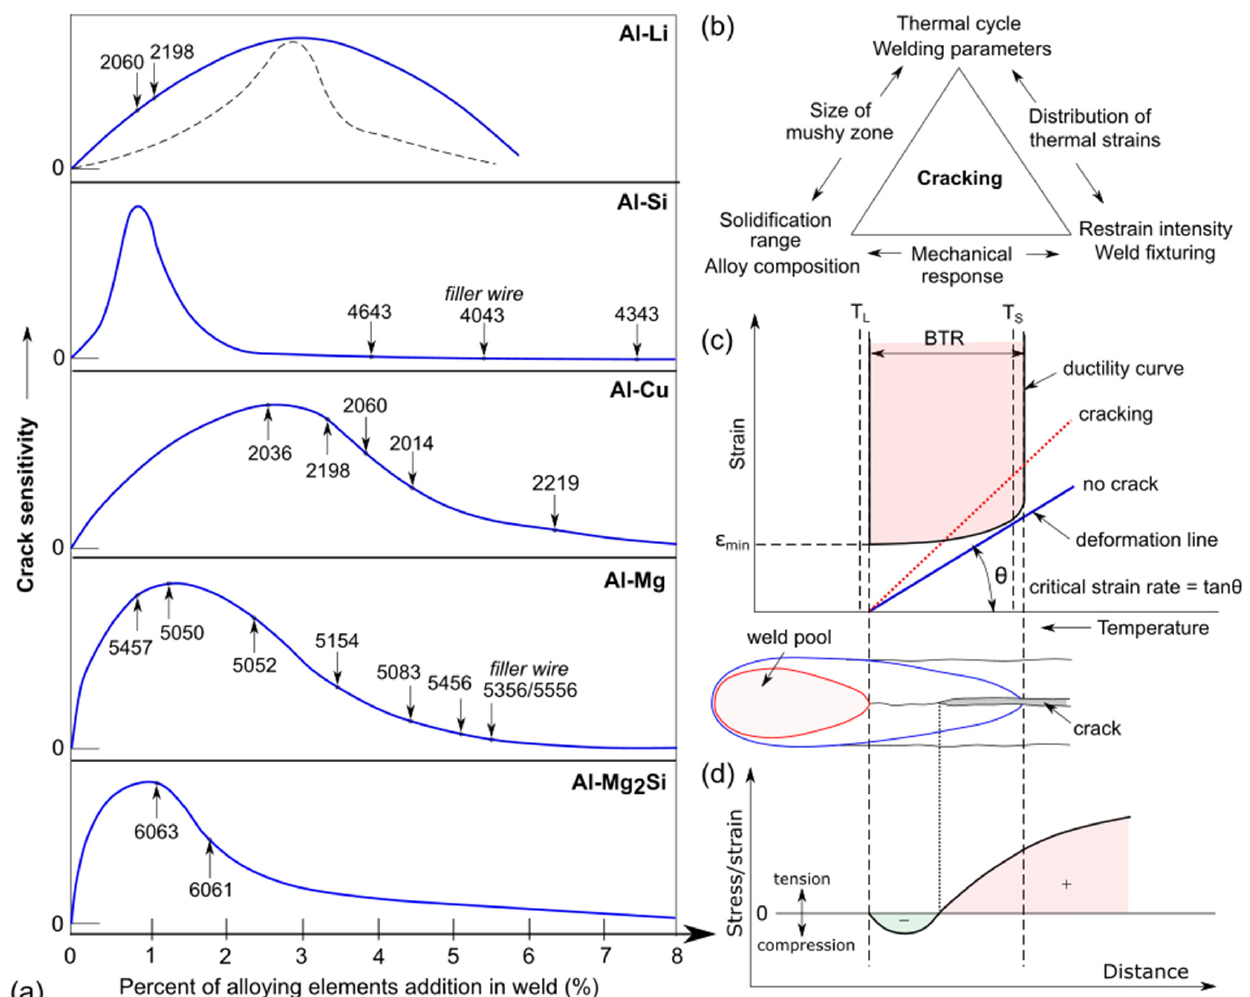
Figure 14. ( a ) Metallurgical cracking susceptibility based on effect of alloying element and solute concentration, based on [29,30,198]. ( b ) Factors affecting cracking occurrence [197]. ( c ) Mechanical cracking susceptibility based on critical strain [197]. ( d ) Typical distribution of transversal stresses and strains in mushy zone, based on [191,197].